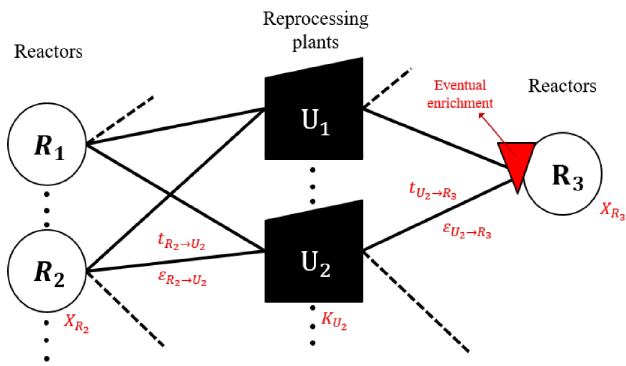
Fig. 1. SEPAR working